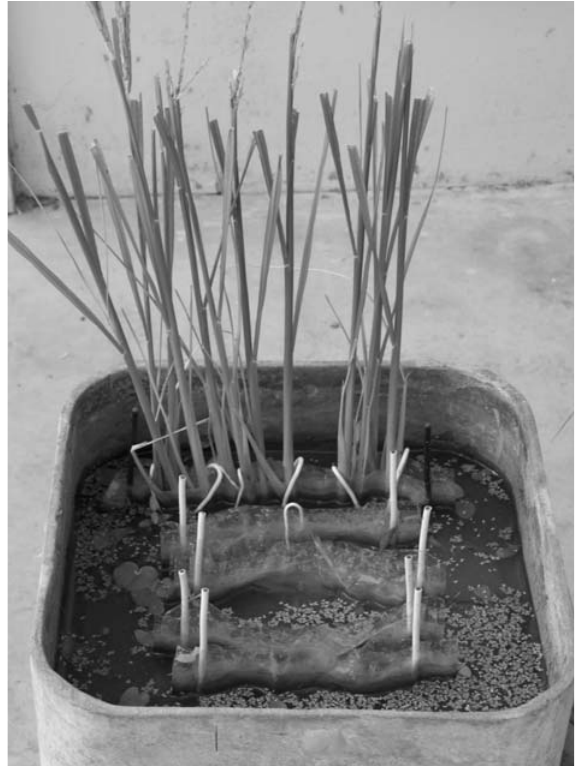
Figura 1. Plantas de arroz alocadas no saco de vinil enterrado no solo alagado.